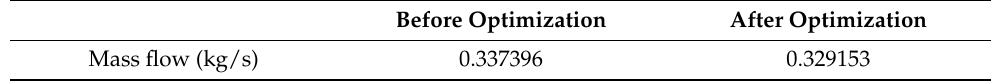
Table 5. Total air mass flow of guide channels before and after